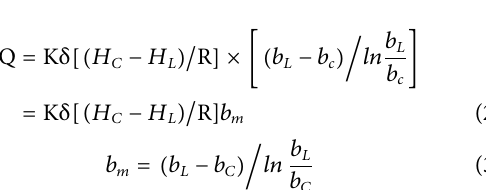
Frontiers in Built Environment |